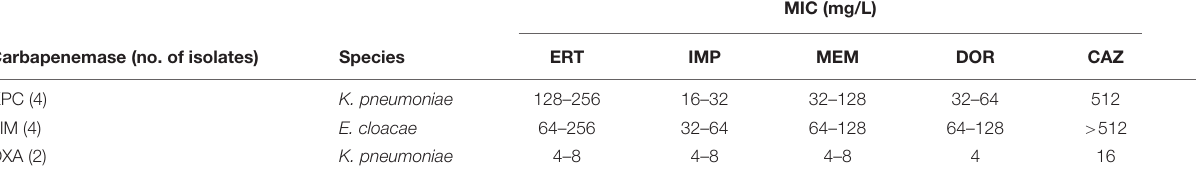
TABLE 1 | Acquired-carbapenemase-producing isolates tested.